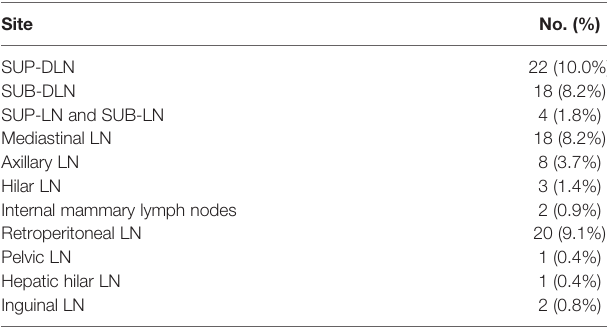
TABLE 2 | The distribution of distant lymph node metastasis.